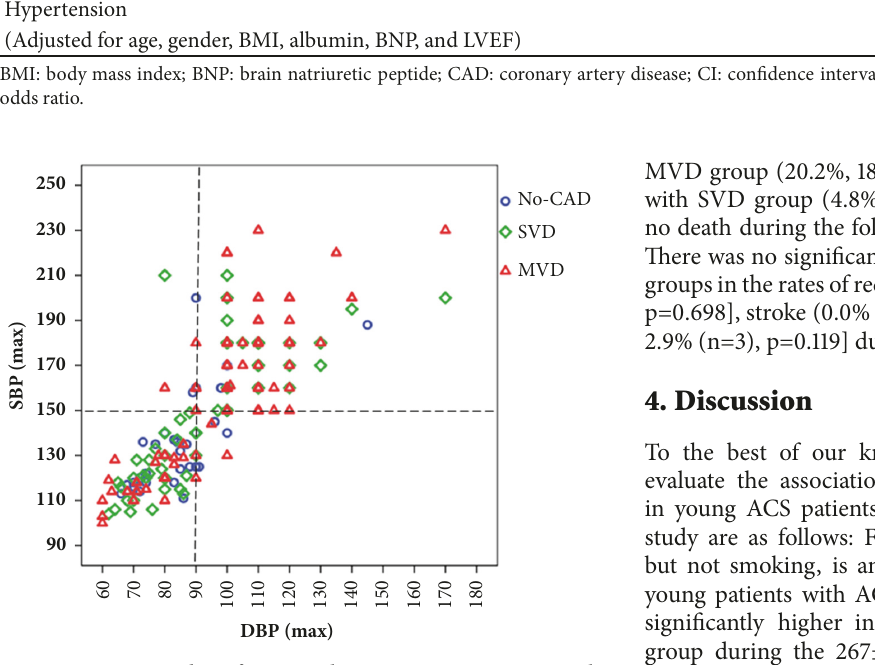
Figure 2: Scatter plot of SBP and DBP among patients with no-CAD, SVD, and MVD . Note that incidence of hypertension [SBP > 150mmHg (y-axis) and/or DBP > 90mmHg (x-axis)] was significantly higher in MVD patients (75 out of 104, 72.1%) than in patients with SVD (34 out of 83, 40.5%) and in no-CAD patients (16 out of 37, 44.4%). DBP: diastolic blood pressure; MVD: multivessel coronary artery disease, no-CAD: no coronary artery disease; SBP: systolic blood pressure; SVD: single-vessel